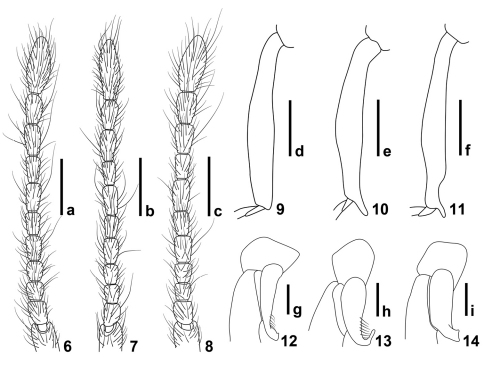
Details of Intestinariusspp., male. 6–8 antenna 9–11 mesotibia 12–14 metatrochanter 6, 9, 12 Intestinarius guangdongensis7, 10, 13 Intestinarius kuzmini 8, 11, 14 Intestinarius longiceps. Scales: a–c = 0.3 mm, d–f = 0.2 mm, g–i = 0.1 mm.